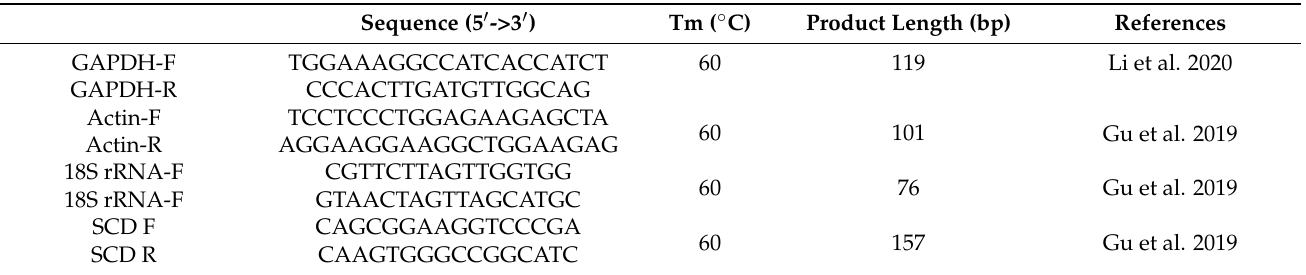
Table 1. Pairs of primers used for Real Time